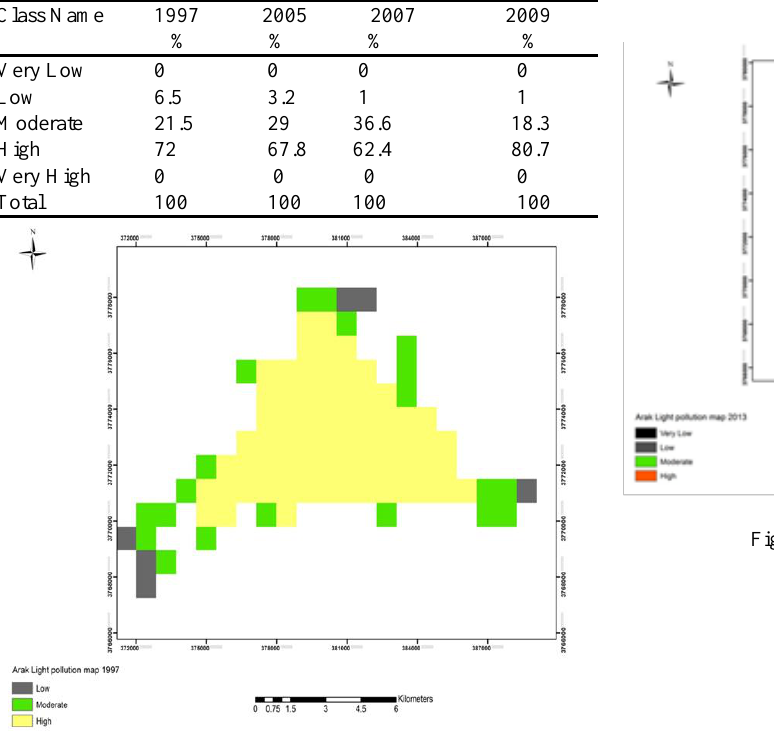
Table 1- Percentage of light pollution in 1997-2009